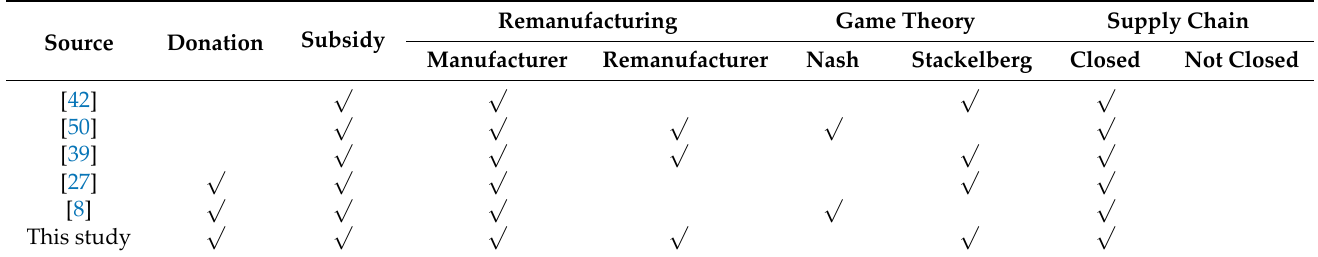
Table 1. Overview of recent literature.